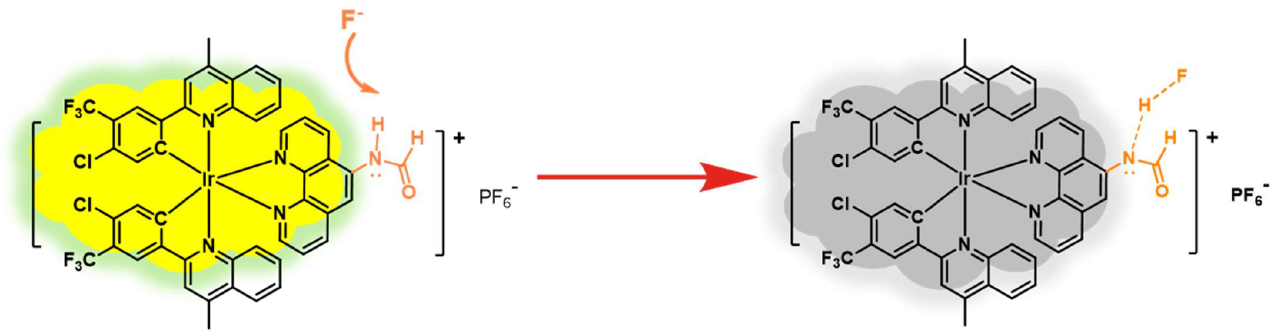
Figure 4. The working mechanism of the F − probe.